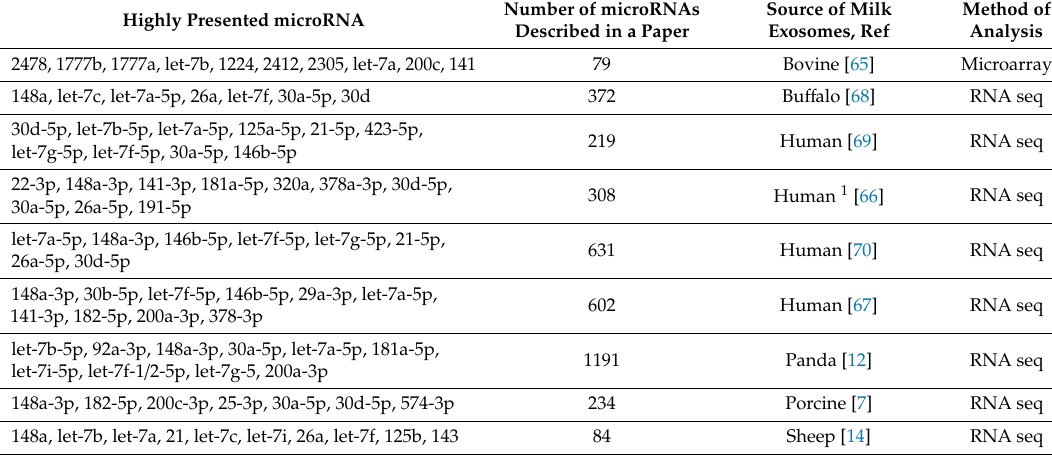
Table 2. Highly represented microRNA of milk exosomes.